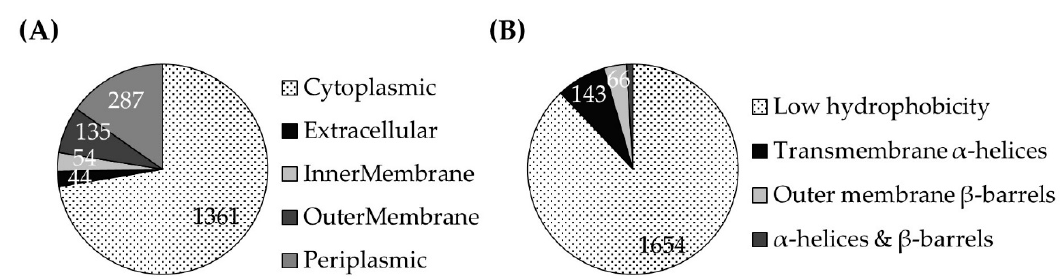
Figure 1. Sequence-based prediction of subcellular localization and hydrophobicity of 1,881 proteins of the Prevotellaceae family as identified in the rumen ecosystem. ( A ) Results obtained from the Cello algorithm (cello.life.nctu.edu.tw/) which differentiates between four cellular compartments and extracellular proteins. ( B ) The combined results of the TMHMM Server v. 2.0 (cbs.dtu.dk / services / TMHMM / ) and the PRED-TMBB2 (compgen.org / tools / PRED-TMBB2 / ) algorithms which assign hydrophobic stretches ( α -helices and β